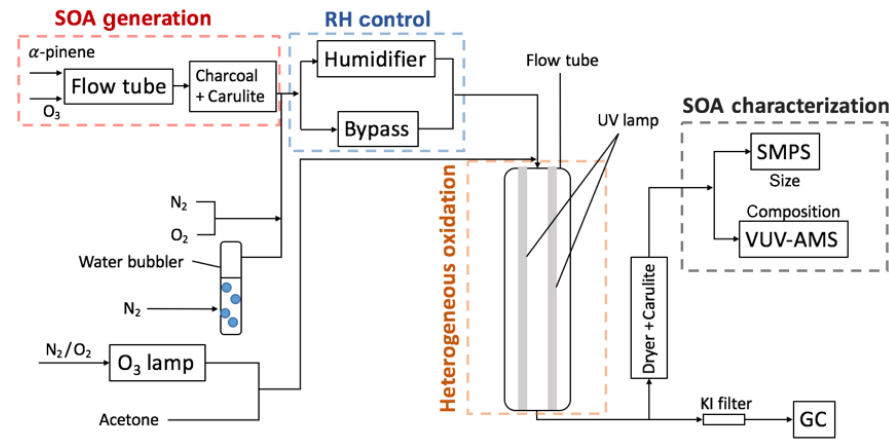
Figure 1. A schematic of the experimental setup for heterogeneous oxidation of SOA. Table 1. Experimental conditions for SOA generation and heterogeneous oxidation. SOA precursors SOA conditions Experimental